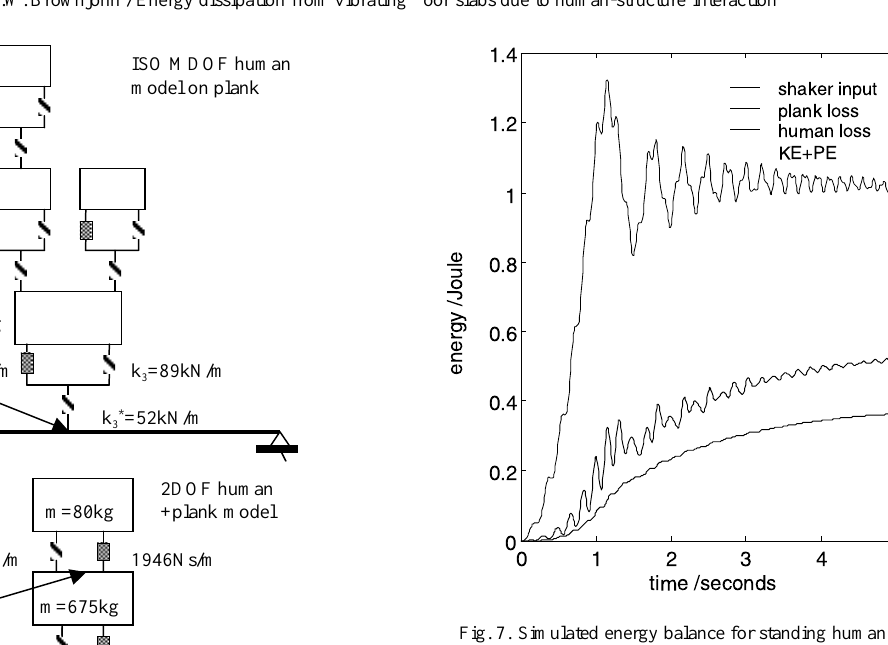
Fig. 7. Simulated energy balance for standing